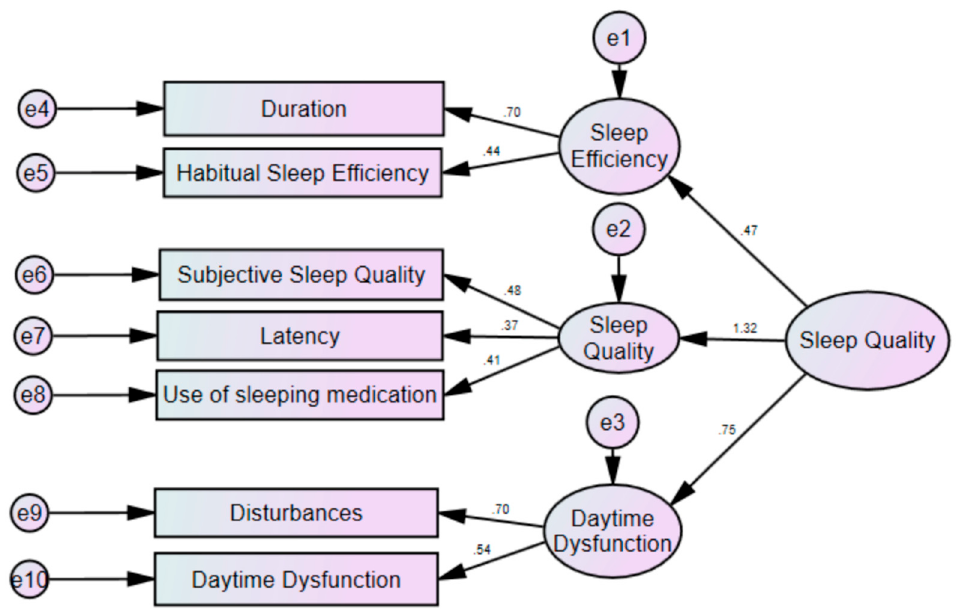
Figure 1. Model fit of the Pittsburgh Sleep Quality Index (PSQI); results from the structural equation modelling.